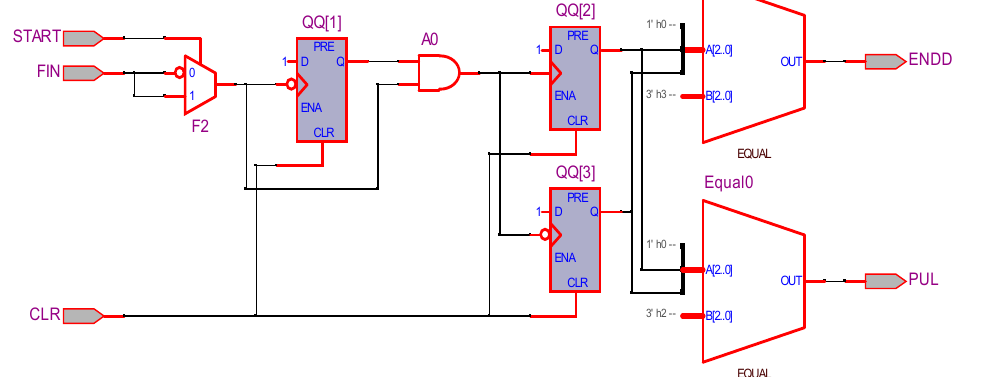
Figure 6. Pulse width measurement and duty cycle control block.